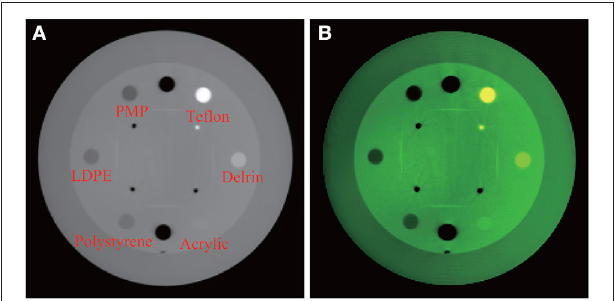
FIGURE 1 | Experiment with Catphan 504. From left, (A) reconstructed image at monochromatic 70 keV with labels of various materials; (B) synthesized color